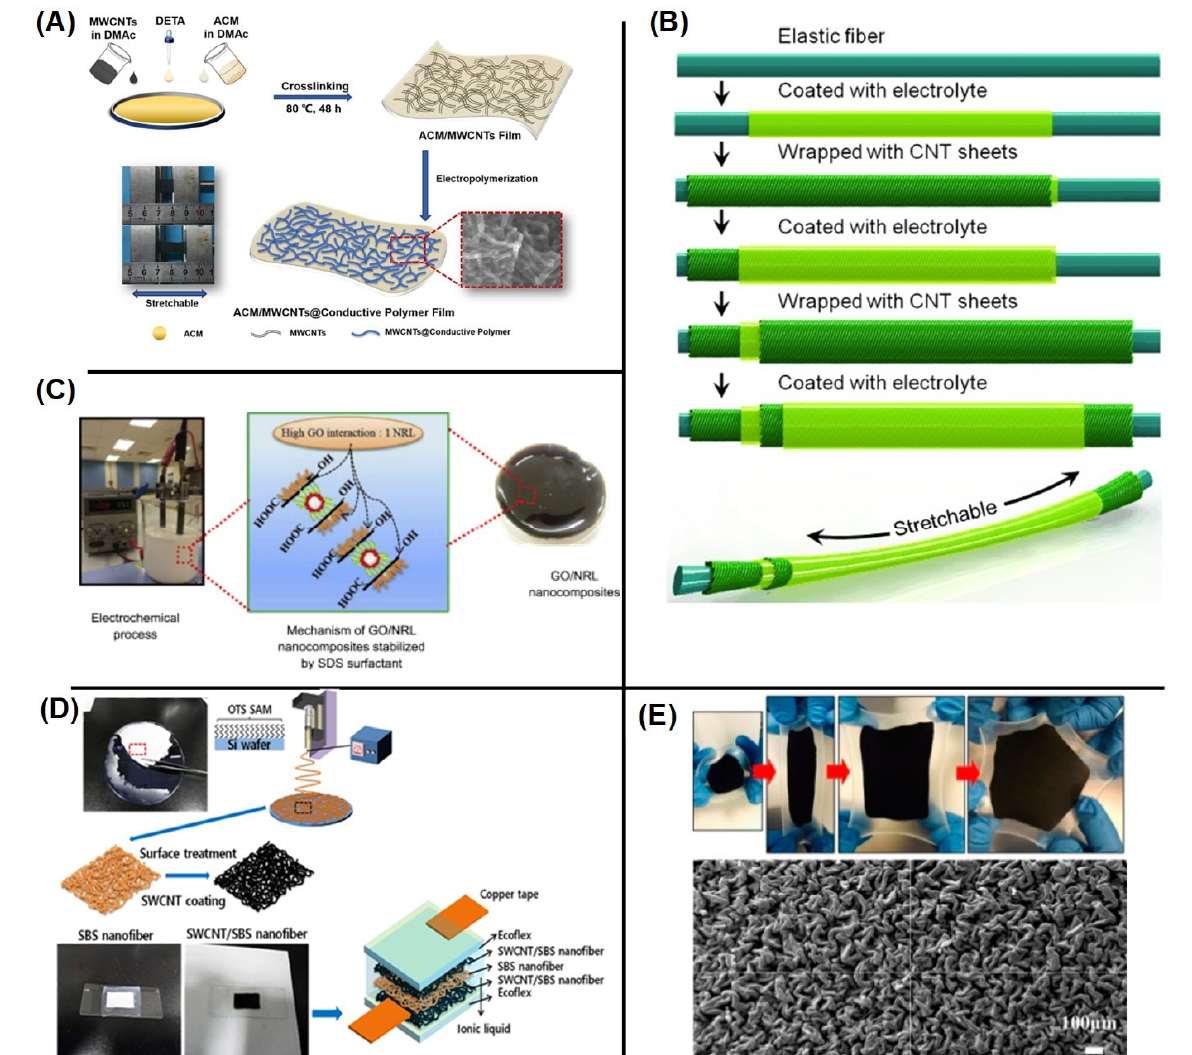
Figure 5. Fabrication process of ( A ) stretchable ACM/MWCNTs@CP film electrodes [49], ( B ) stretch- Figure able, fiber supercapacitor [51], ( C ) graphene oxide/natural rubber latex nanocomposites [52], ( D ) CNT-deposited rubber nanofiber electrode-based supercapacitor [53] and ( E ) isotropic buckled CNT films [54]. Reproduced with permission from ref. [49,51–54].